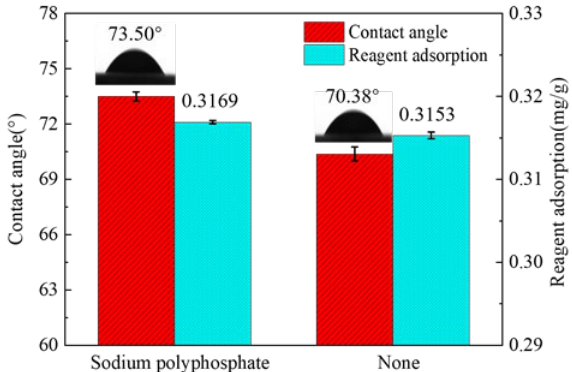
Figure 6. Collector adsorption and contact angle measurement results.